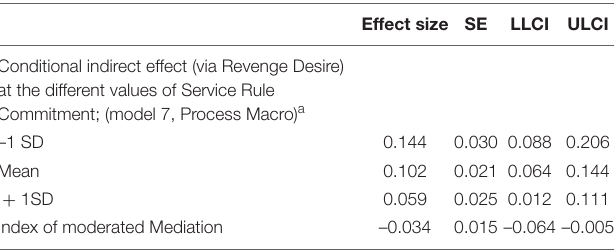
TABLE 4 | Results of conditional indirect effects of customer mistreatment on coworker undermining at different values of service rule commitment (SRC). Effect size SE LLCI